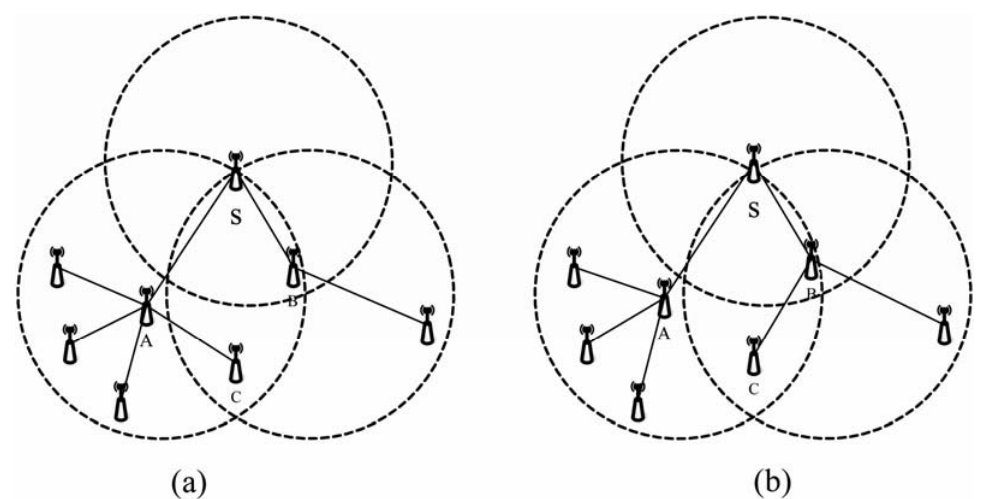
Figure 5. Balancing process. ( a ) No balancing method is applied. ( b ) Balancing method is